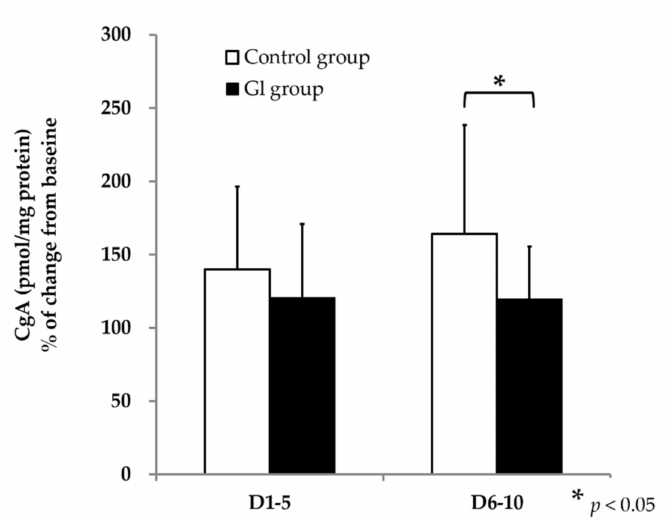
Figure 2. Stress condition marker (CgA pmol/mg protein) represented as percentage (%) of change from baseline to D1–5 or D6–10 in the sodium-restricted diet control group (white) and Glu group (black) and its standard deviation. In D6–10 CgA (pmol/mg protein) value as stress condition showed that Glu group value was significantly lower than control group diet by paired sample t -test ( n = 23) ( p =